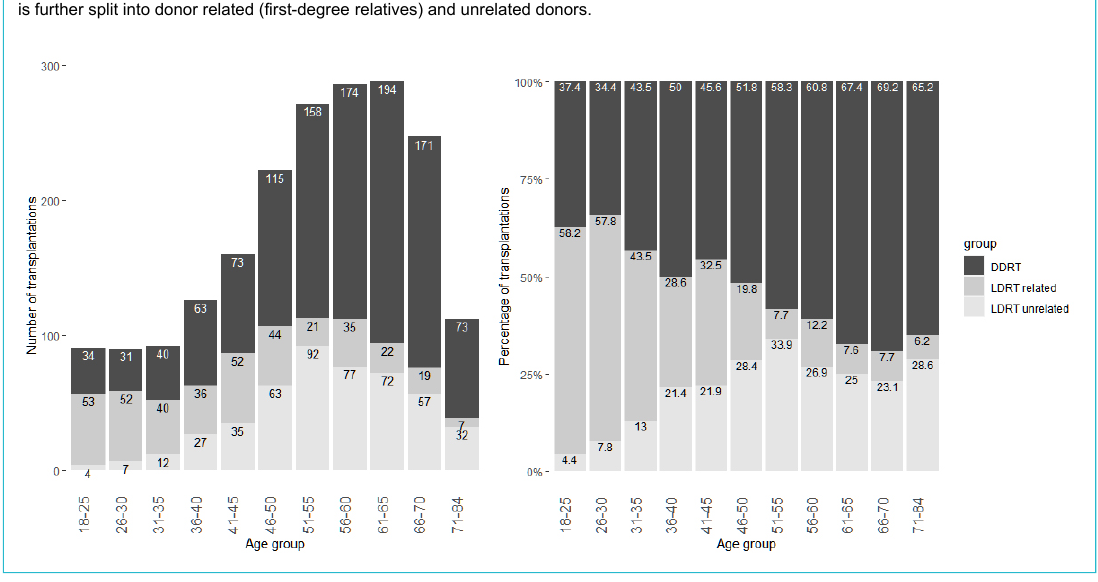
Table 2: Odds ratios, 95% confidence intervals (CIs) of multivariable and univariate logistic regression with outcome living donor renal transplant on complete data set (n = 1558).